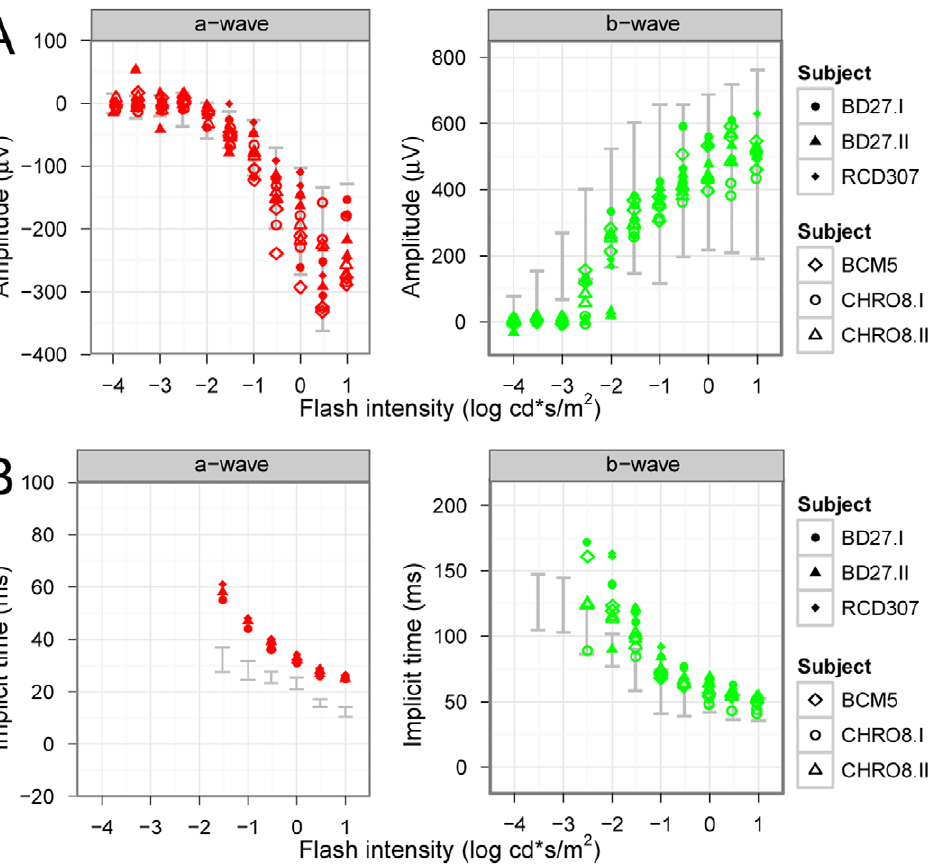
Figure 4. Intensity-response function kinetics under scotopic conditions. The single flash response a- and b-wave amplitudes (A) and implicit times (B) to increasing stimulus intensities are presented for both groups (upper subjects: NOP group, lower subjects: ALP group; the 95% confidence band of normal subjects is marked with grey). While the a-wave amplitude slowly and continuously increases, the b-wave amplitude stays low until the flash intensity reaches 2 2.5 log cd*s/m 2 . While peak implicit times of the a-wave responses are prolonged for all flash intensities, the implicit times of the b-wave approaches the normal range with increasing flash intensity.